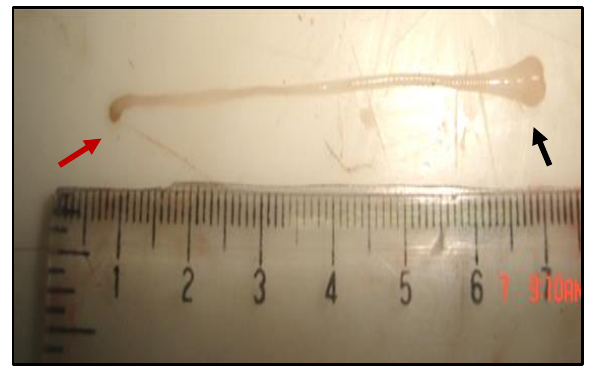
Figure, 2: Liver shows a small white-yellow color tape worm (6 cm) long appeared which has a rostellum and scolex ( ) with vesicle filled with fluid at the end of the worm ( ).